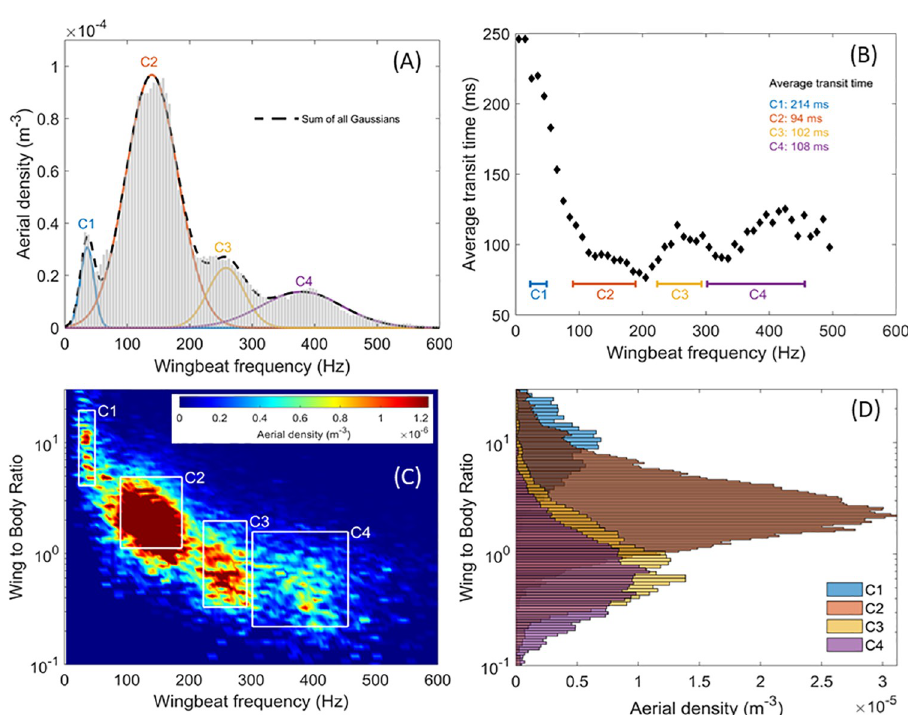
Fig 5. Distribution of the wingbeat frequency corrected in temperature (A) with four Gaussian fits corresponding to each insect cluster, and the total reconstructed gaussian fit (dashed black line). Average transit time in function of the wingbeat frequency (B), the different cluster range are displayed, and their mean transit time indicated. Aerial density per bin of wing to body ratio and wingbeat frequency (C), the boundaries of the four insect clusters C1 to C4 are indicted by white lines. Distribution of the wing to body ratio separated per cluster (D).